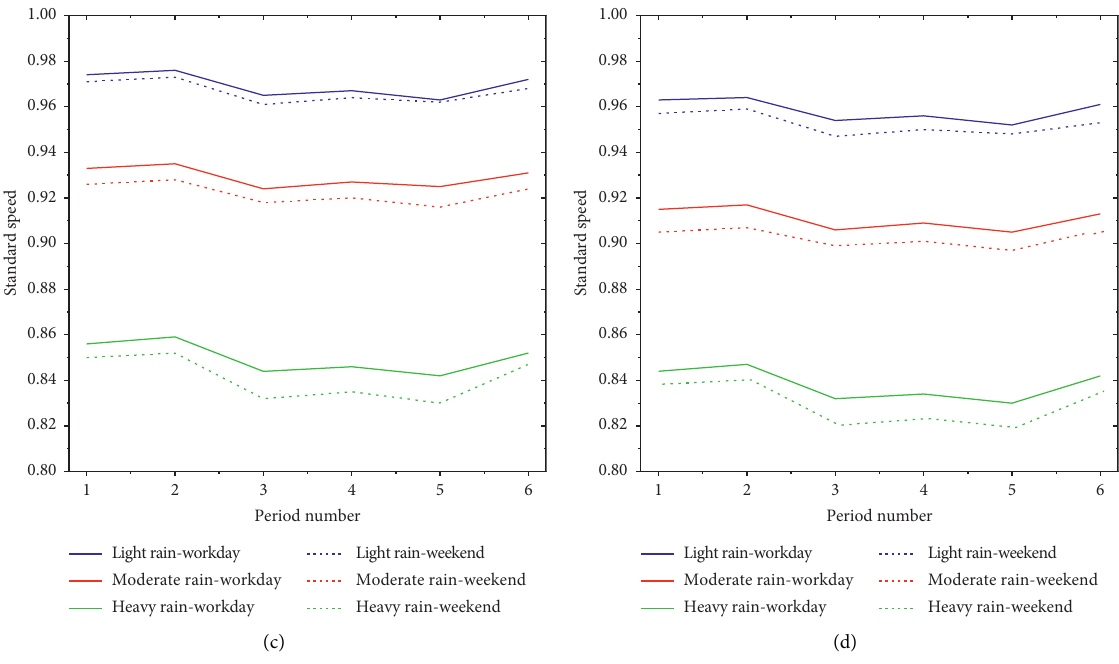
Figure 3: Time distribution characteristics of standard speed of highway in rainy environment: (a) Beijing-Harbin Highway; (b) Beijing- Tianjin Highway; (c) Beijing-Kaifeng Highway; (d) Beijing-Taipei Highway.